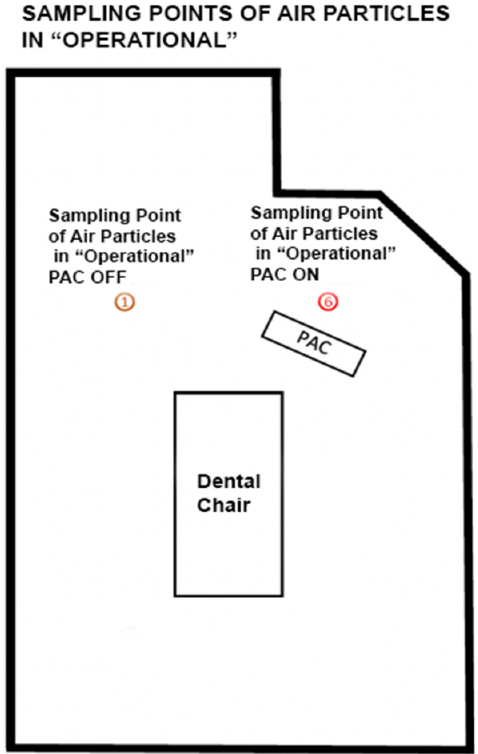
Figure 4. Planimetry of the experiment. PAC = Portable air cleaners.